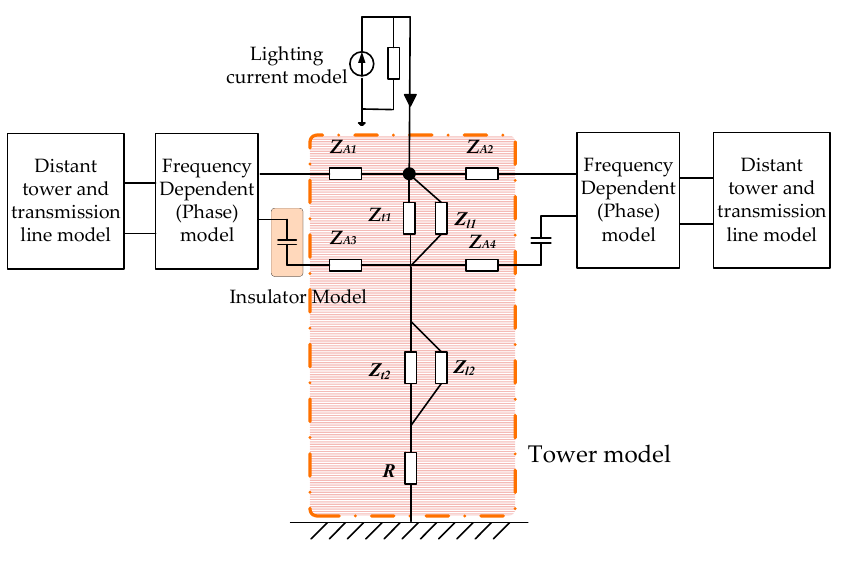
Figure 10. Tower model.